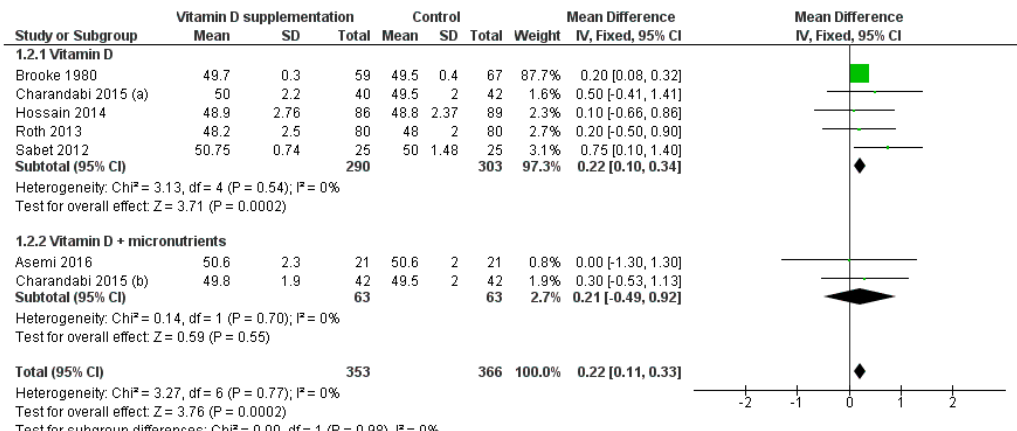
Figure 3. Forest plot of the effect of vitamin D intervention alone or in combination with micronutrients on birth length (cm), based on the fixed-effects model. Charandabi 2015 ( a ): Vit D + Ca (1000 IU/day); Charandabi 2015 ( b ): Vit D (1000 IU/day).